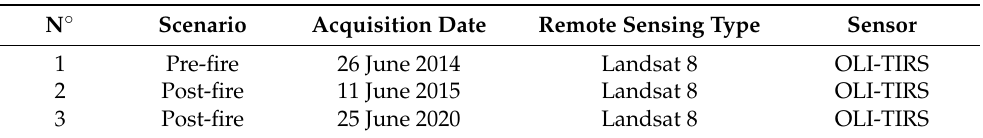
Table 1. Remote sensing data. N ◦ Scenario Acquisition